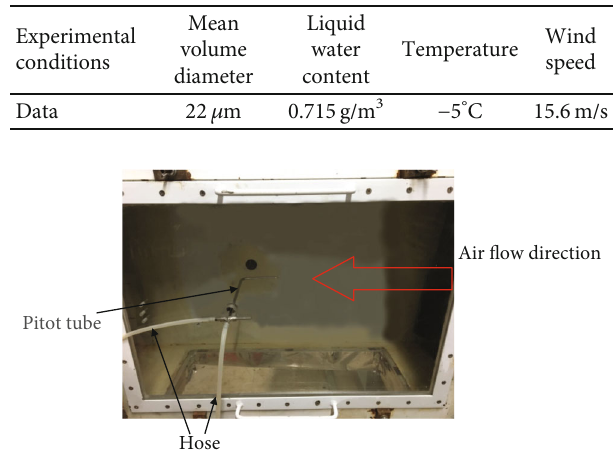
Table 2: Parameters of ice blocking experiment A.